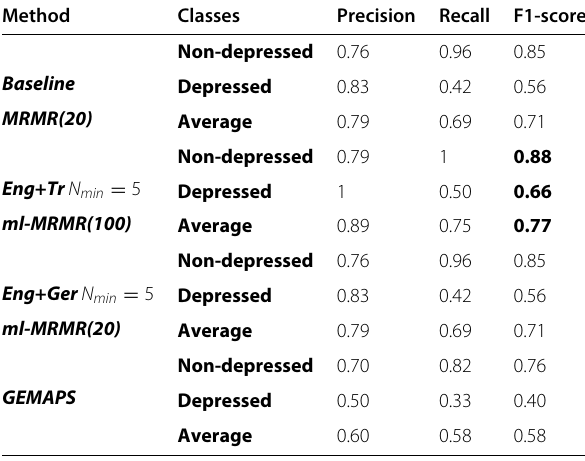
Table 7 Best classification results for the development set of the English task. Multi-lingual methods annotated with ml. There are 23 non-depressed and 12 depressed subjects in the database. Avec 2013 feature set used for all results except Gemaps tab. Number of selected features are shown in parenthesis for each case. Improvement with ml-MRMR using the Turkish database is